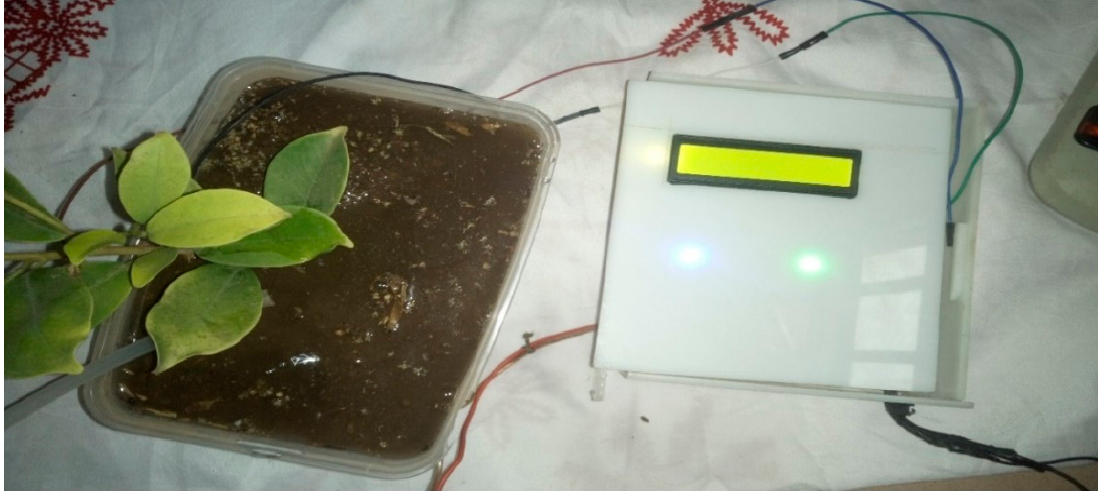
Figure 9. Prototype testing in highly moist soil (Moisture level 410%).